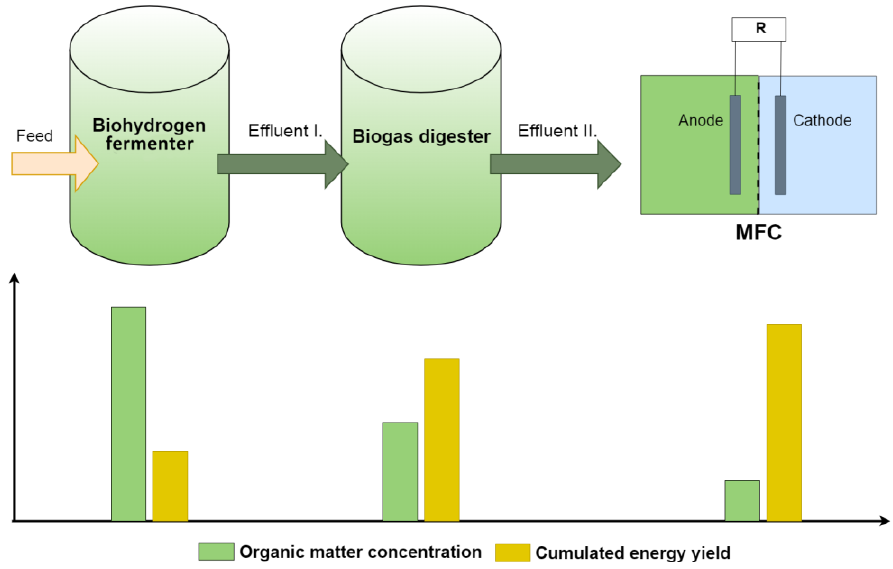
Figure 9. Conversion scheme of cascade biosystems.